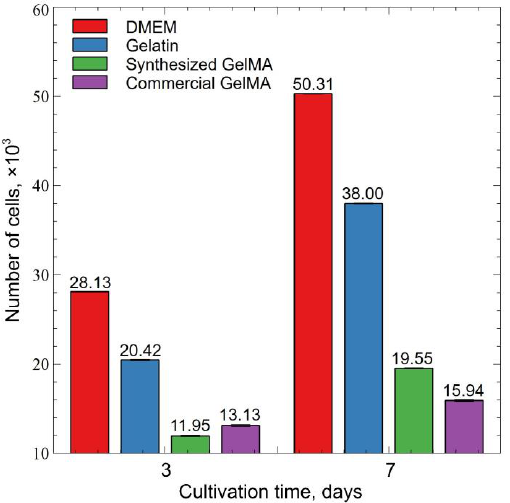
Figure 4. Proliferation of ADSCs in DMEM without gelatin, in the presence of unmodified porcine skin gelatin (type A, Bloom 300), synthesized, and commercialized by GelMA. For each group, the number of cells ( X S X ) is shown on the 3rd and 7th days after seeding.